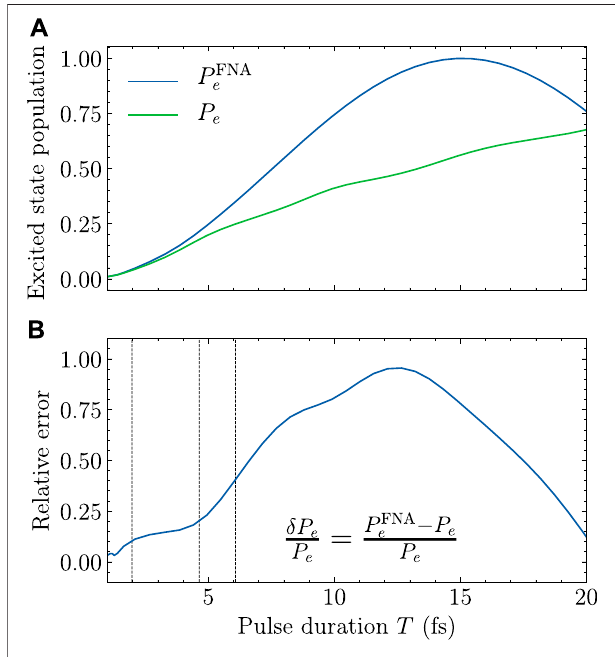
FIGURE 1 | Population of the fi rst electronically excited state of HCCI + versus the pulse duration T , at t = t f when the laser pulse is switched off. The maximum-amplitudeoftheelectric fi eld E max is2 GV/m. (A) P e ( t f )and P FNA e ( t f ) obtained by multidimensional nuclear dynamics (green) and by the frozen nuclei approximation (blue), respectively. (B) The relative error δ P e P FNA e ( t f ) with respect to P e ( t f ). Vertical lines show the positions of δ P e 20%, and 40%,